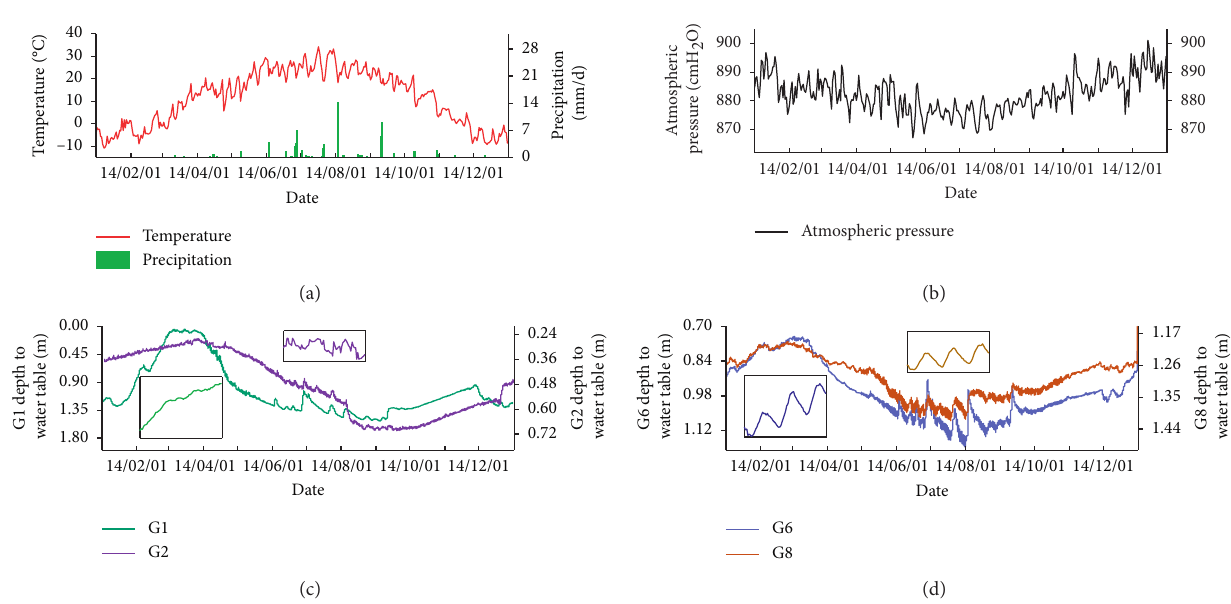
Figure 2: Daily temperature, precipitation, atmospheric pressure, and hourly groundwater level (GWL) fluctuations at observation sites G1, G2, G6, and G8 in 2014: (a) temperature and precipitation; (b) atmospheric pressure; (c) GWL fluctuations at observation sites G1 and G2, where no regular diurnal fluctuations were detected; (d) GWL fluctuations at observation sites G6 and G8, where regular diurnal fluctuations were detected. The insets in (c) and (d) are derived from the corresponding groundwater level from June 5 to June